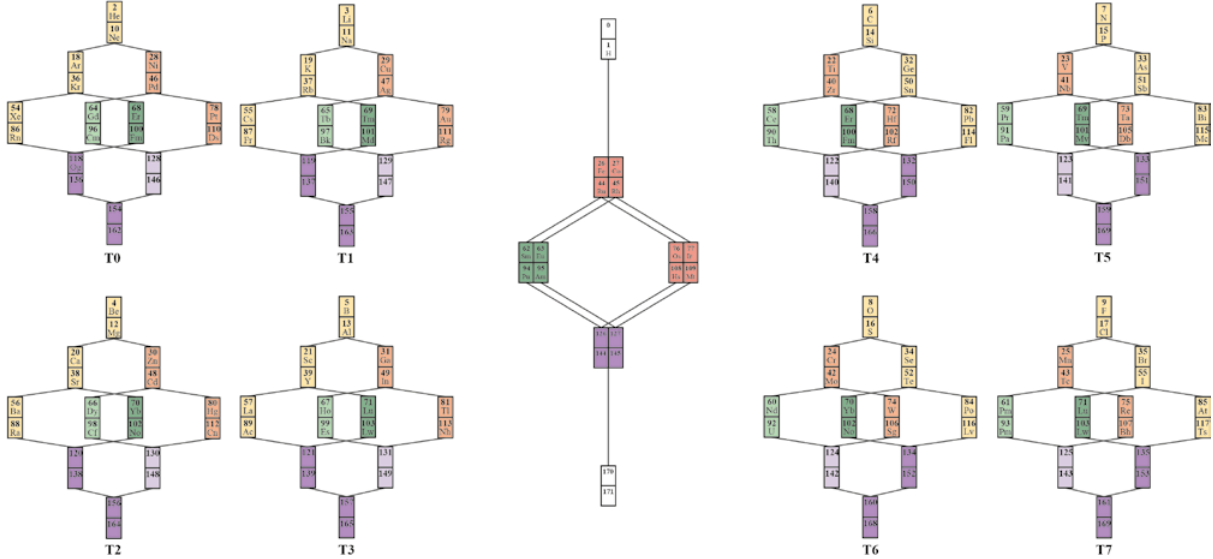
Figure 2. The nine periodicity trees make up the